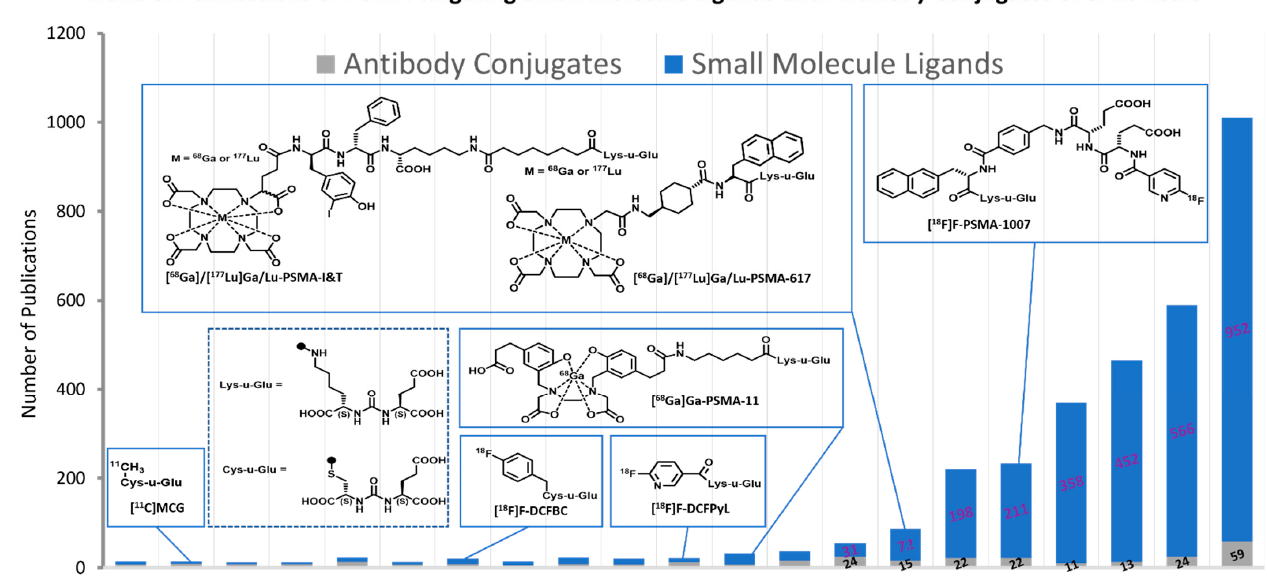
Figure 2. An exponential trend of publications is observed on reporting the chemical modifications and applications of small molecule PSMA-targeting agents since the initial report of [ 11 C]MCG in 2002. Data were obtained from SciFinder covering journal publications of structural investigation and pre-clinical/clinical applications of PSMA-targeting small molecules and antibodies in English. Shown in the figure are representative chemical structures and their corresponding first publication